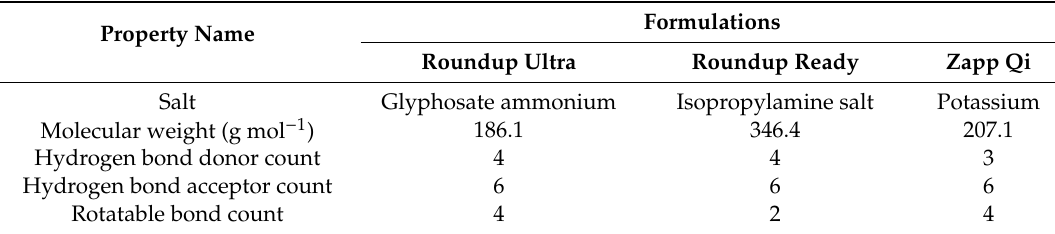
Table 4. Physical and chemical properties of glyphosate